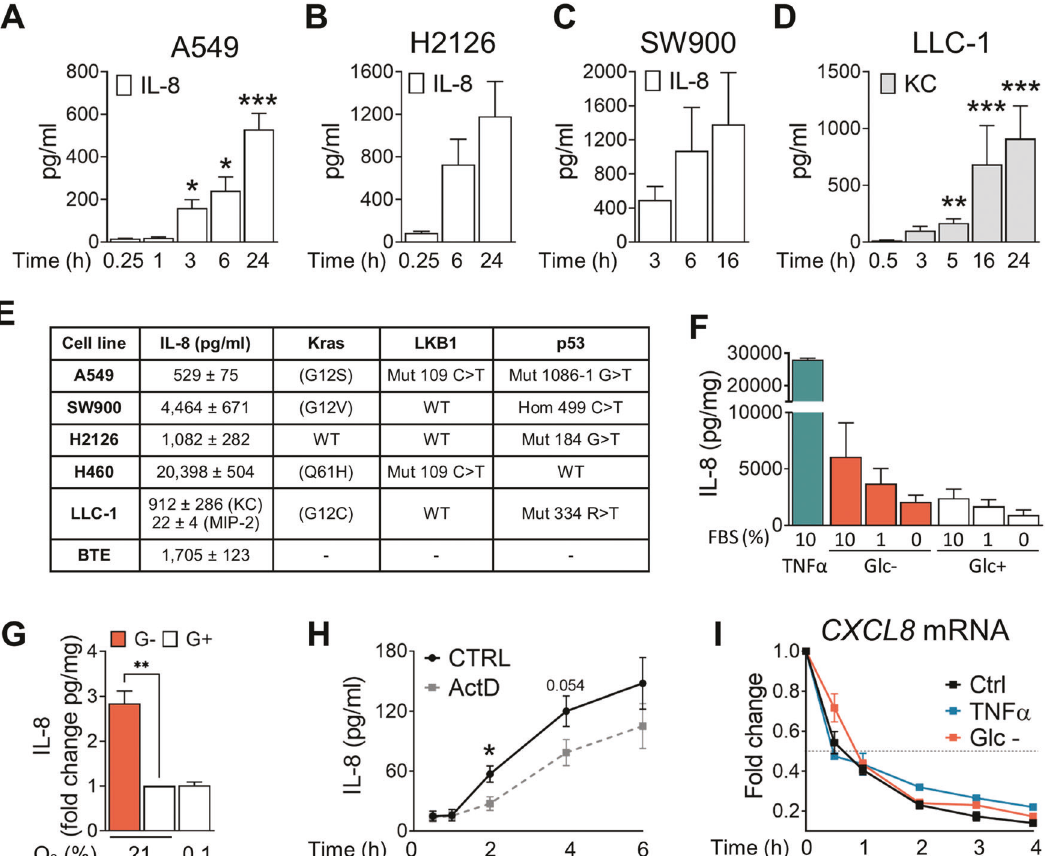
Fig. 1 Lung cancer cell lines with different genetic backgrounds secrete IL-8 in nutrient-poor and nutrient-rich conditions. A A549 cells were plated and incubated in media containing glucose 25 mM supplemented with 10% dialyzed FBS for the times shown. IL-8 protein concentration was measured by ELISA. Results are expressed as Mean ± SEM of at least 4 experiments. B , C H2126 and SW900 cells were plated and incubated for the indicated time points. IL-8 was measured by ELISA. Results are expressed as Mean ± SEM ( N = 3). D Lewis Lung Carcinoma cells were seeded and the supernatant was collected at indicated time points to analyze the IL-8 orthologue KC by ELISA. Results are expressed as Mean ± SEM ( N = 3). E Table representing signi fi cant mutations of the lung cell lines and the amount of IL-8 they secrete 24 h after medium replacement. F A549 cells were plated and incubated in media with different concentrations of dialyzed FBS (dFBS), with TNF α (10 ng/ml) or with media deprived of glucose (0 mM), as indicated for 24 h. IL-8 was measured by ELISA. Results are expressed as Mean ± SEM ( N = 4). G A549 cells were plated for 24 h at normal conditions. Cells were then incubated at 0.1 or 21% of O 2 in the hypoxic chamber for 24 hours. Supernatant were collected and secreted IL-8 measured. Results are expressed as Mean of fold change of pg of IL-8 / mg of proteins from cells in culture ± SEM ( N = 3). H A549 cells were pretreated with 80 nM Actinomycin D (ActD) for 1 h; then cells were cultured in glucose- rich media in presence or absence of ActD (80 nM) supplemented with 10% dFBS for the indicated time points (0.5 – 6 h). Secreted IL-8 was measured by ELISA. Results are expressed as Mean ± SEM ( N = 3). I A549 cells were pretreated with either TNF α (10 ng/ml + Glc 25 mM), glucose (25 mM) or without glucose (0 mM) for 3 h. Then media was replaced with fresh treatment media also containing ActD (80 nM) for times shown (0.25 – 4 h). CXCL8 mRNA decay was measured for each condition. Results are expressed as Mean fold change ± SEM ( N = 3, except for TNF α that is equal to 2). Statistical analysis was performed for A – D using a paired t -test comparing to the shortest time point,